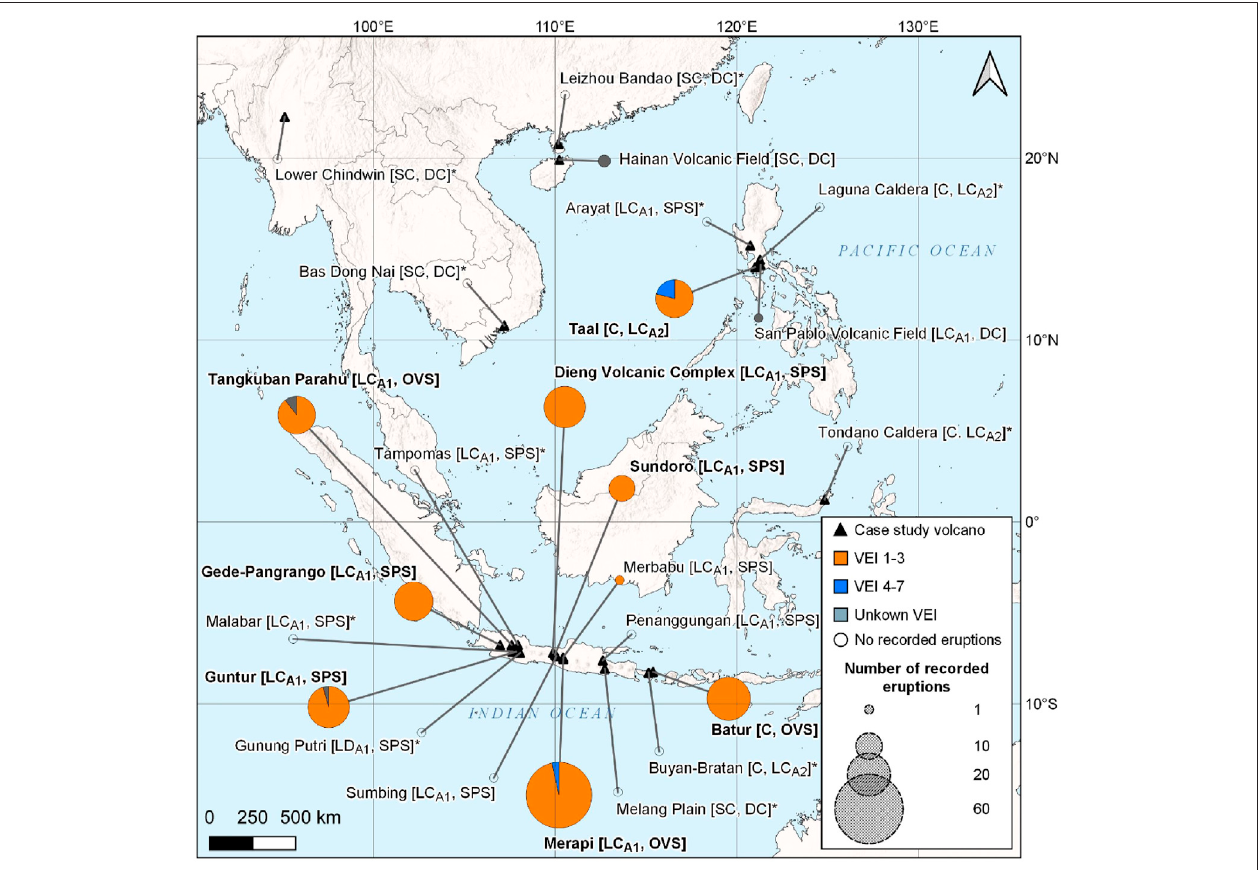
FIGURE6| Thenumberofrecordederuptionsandtherelativeproportionofsmall(VEI < 4),large(VEI4+),andunknownVEIeruptionswithintherecordconsidered complete using the 50th percentile change point for the 24 volcanoes with PEI 7 considered in this study. Bolded volcano name indicates that we used the Bayesian updating method to update frequency-magnitude estimates. Analogue classi fi cation used by Jenkins et al. (2012), Whelley et al. (2015) in square brackets: LC A1 , Large cone, LD, Lava Dome, SC, Small cone, C, Caldera, DC, Distributed cones and fi elds; LC A2 , Large caldera, SPS, Semi-plugged stratocone, OVS, Open-vent stratocone. Volcanoes with no recorded eruption in the entireHoloceneGVP eruptionrecordare denoted by*. Note: Merbabu A2classi fi cation waschanged from OVS (Whelley et al., 2015) to SPS (this study) as it does not meet the criteria outlined in Whelley et al. (2015).